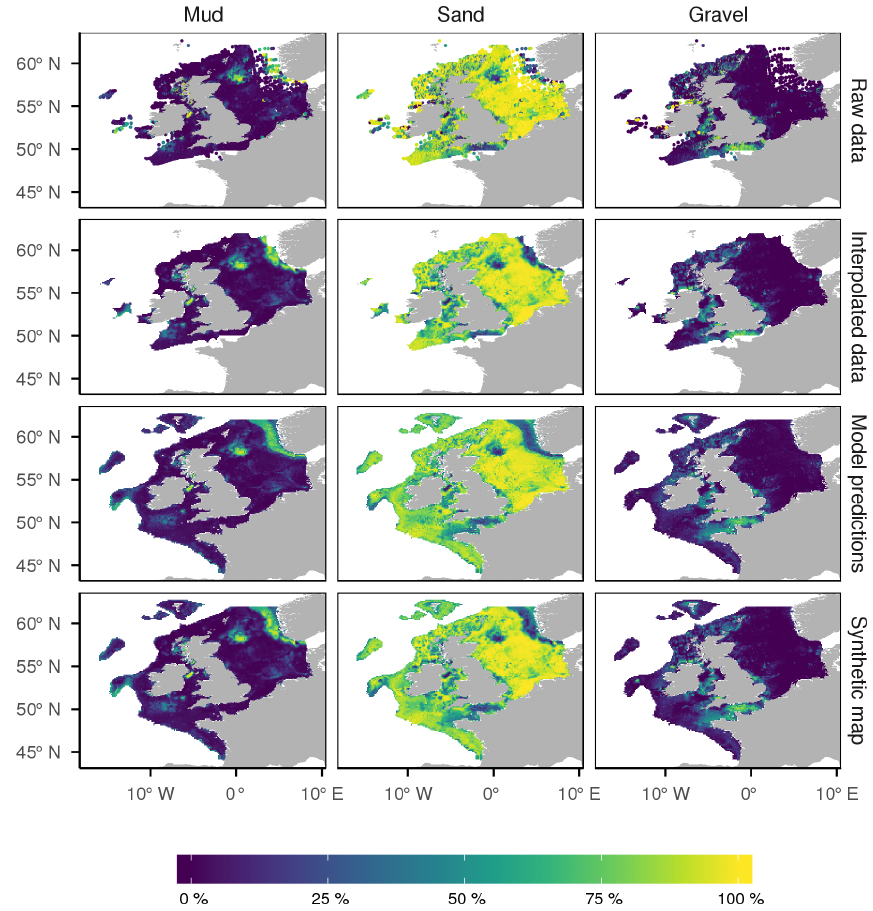
Figure 5. The derivation of the synthetic map of sediment percentages. The interpolated map uses bilinear spline interpolation using sediment data over the region. The random forest map predicts the sediment percentages using a random forest model which relates the percentage to the bed shear stress and the distance to the coast. The synthesized map merges the two by using spatial interpolations where we have data and the random forest predictions where we do